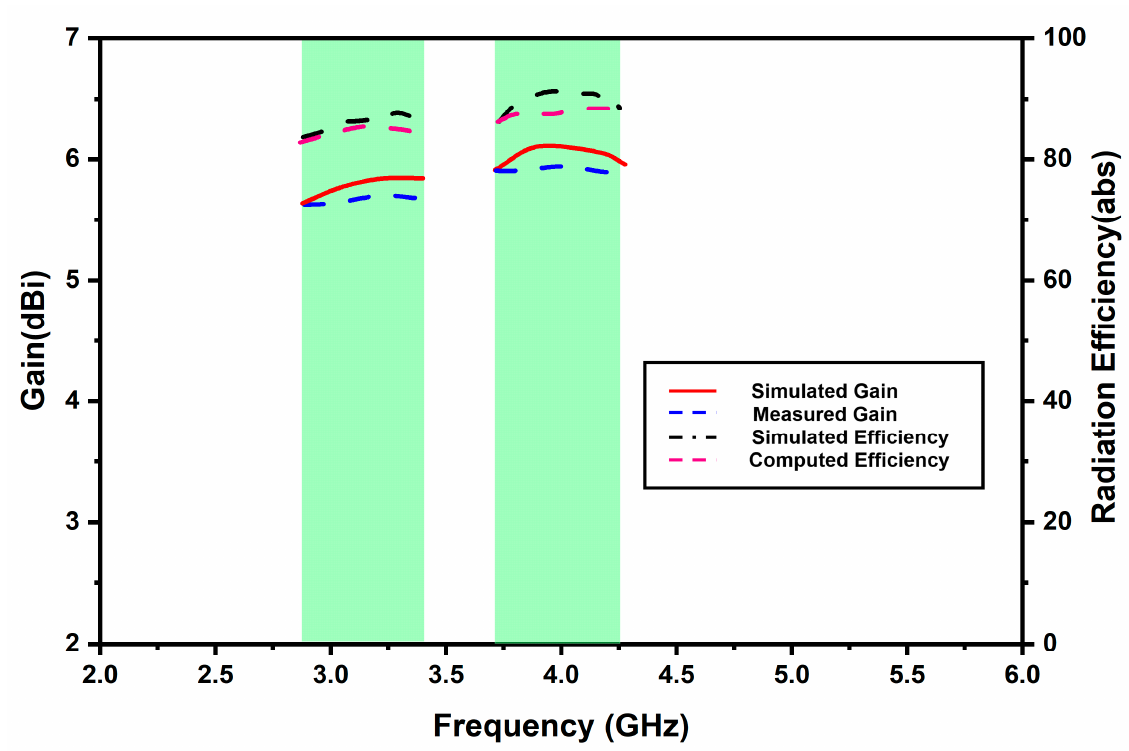
Figure 9. Antenna gain and efficiency against frequency.